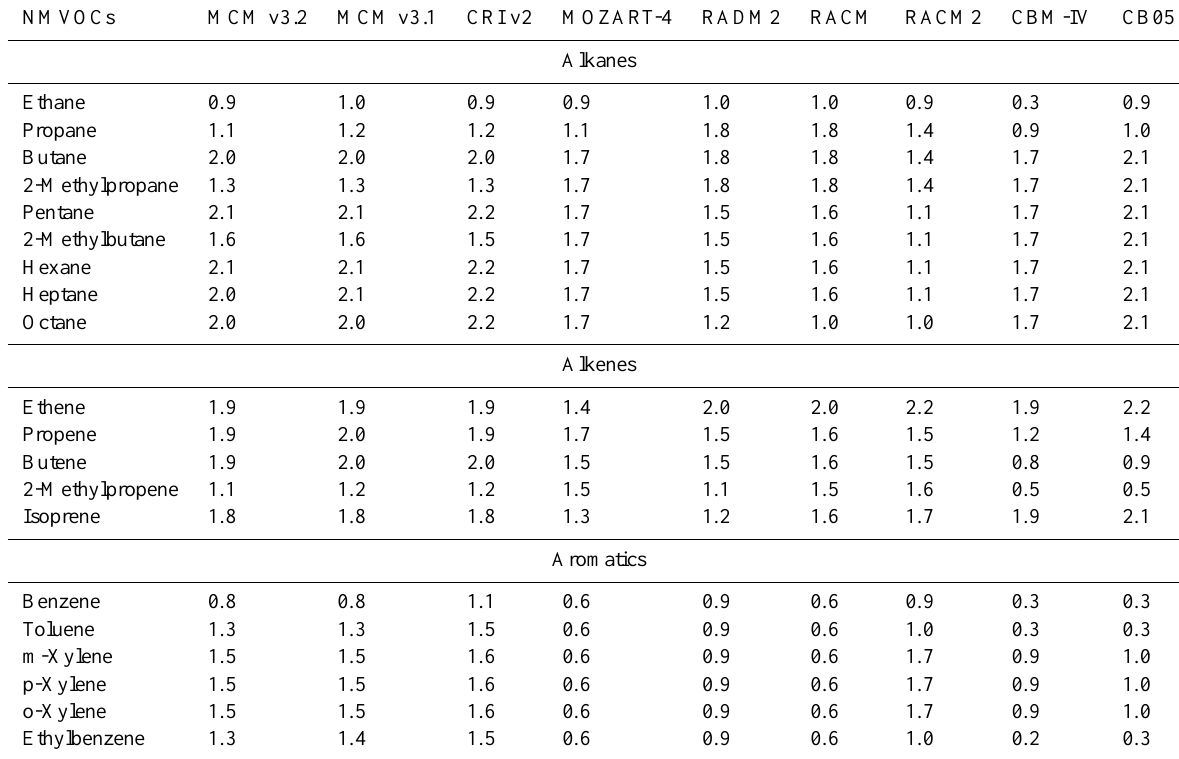
Figure 3. TOPP value time series using each mechanism for each VOC. Table 3. Cumulative TOPP values at the end of the model run for all VOCs with each mechanism, normalised by the number of C atoms in each